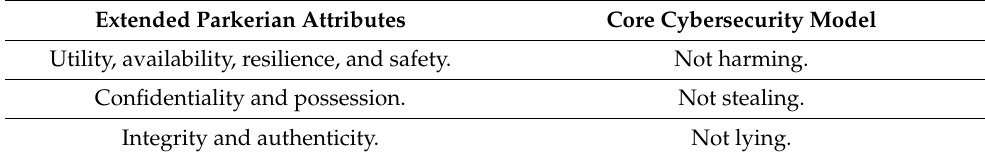
Table 4. Attributes of the Core Cybersecurity framework for construction [65]. Extended Parkerian Attributes